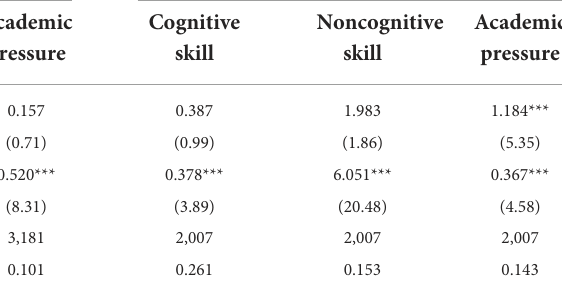
agriculture disasters